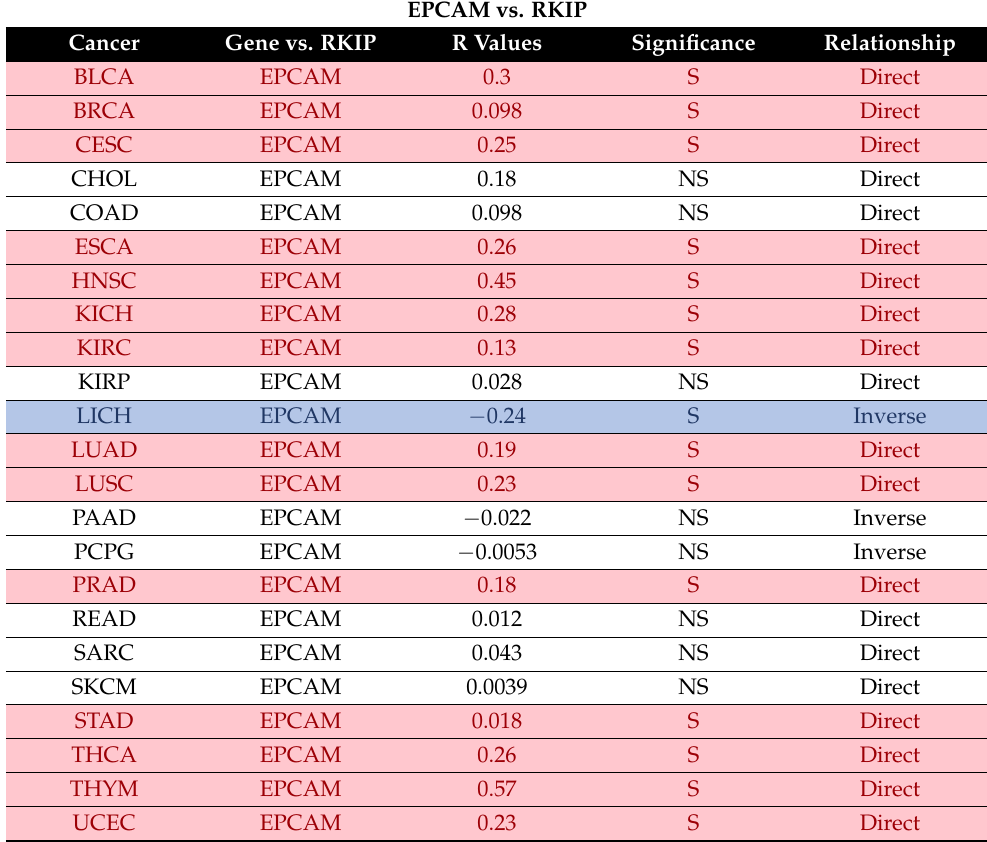
Table 5. RKIP vs. EPCAM. A bioinformatic analysis was performed across 23 different cancer types comparing the presence of RKIP against VIM. From this data, a p -value and an R value were determined for each of the cancer types. The table above organized the bioinformatic data. For each cancer type, the R value was reported in the third column. Significance was determined based on the p -value, with a p -value less than 0.05 indicating a significant value. The relationship between RKIP and EPCAM was determined through the sign of the R value. A negative R value indicated an inverse relationship while a positive R value indicated a direct relationship. The rows highlighted in blue indicate a significant, inverse relationship between RKIP and EPCAM. The rows highlighted in red indicate a significant, direct relationship between RKIP and EPCAM.